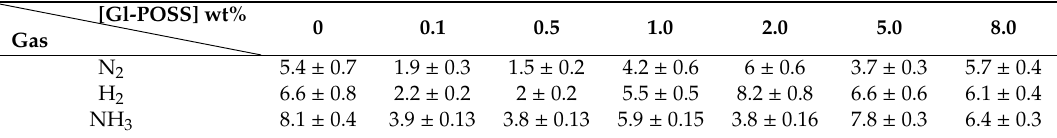
Table 4. The di ff usion coe ffi cients ( D × 10 11 , m 2 s − 1 ) of single